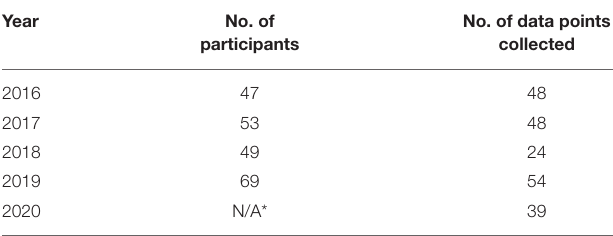
TABLE 2 | Number of event participants and collected